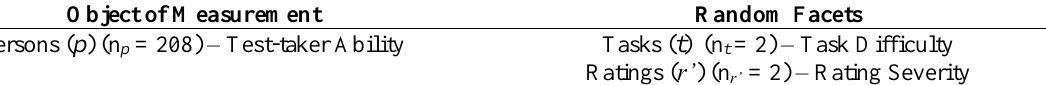
Two-Facet Fully Crossed Design - Random Facets, Object of Measurement Object of Measurement Random Facets